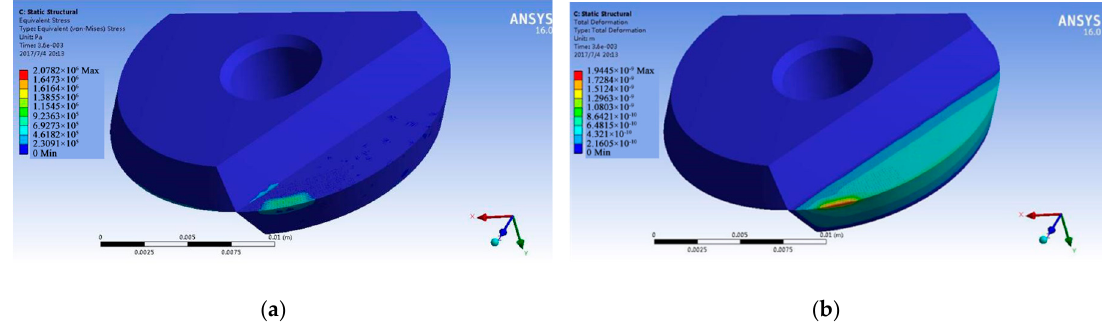
Figure 12. Nephograms showing the simulation results for thermal stress. ( a ) Equivalent stress; ( b ) equivalent displacement.